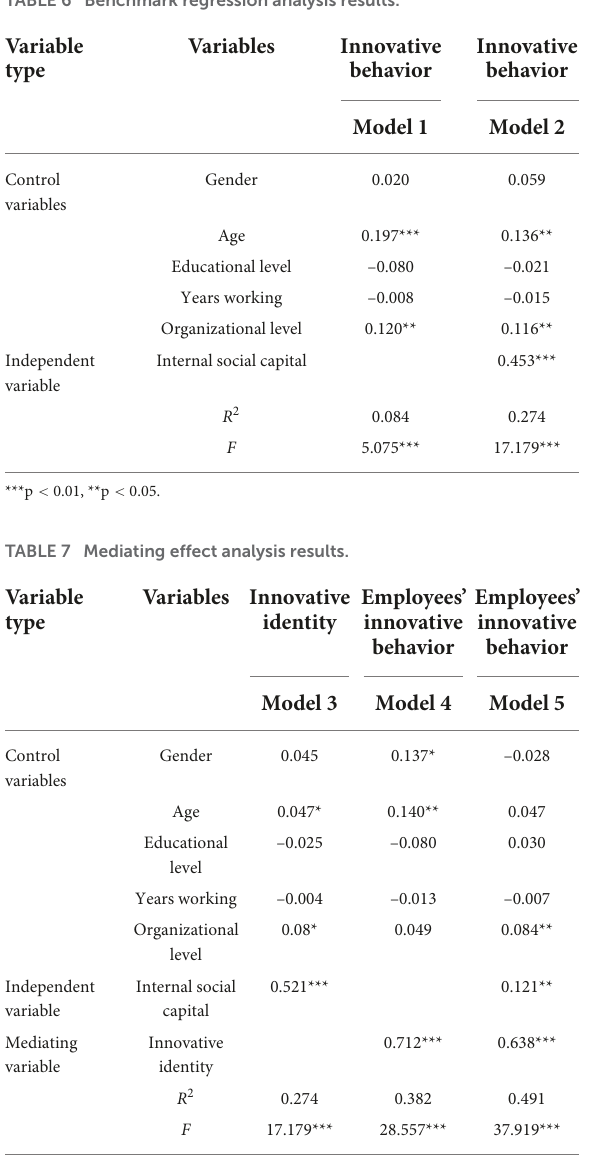
TABLE 6 Benchmark regression analysis results.